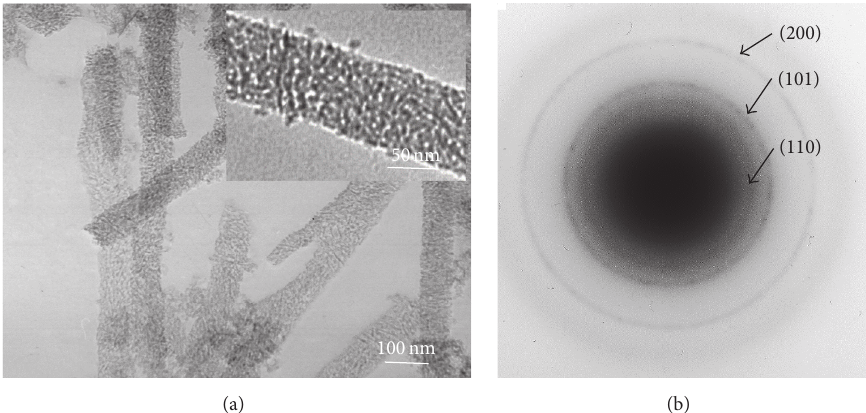
Figure 3: (a) The TEM image of the mesoporous SnO 2 nanowires; the inset shows the high magnification TEM images of the single nanowire. (b) The SAED pattern of the mesoporous SnO 2 nanowires.